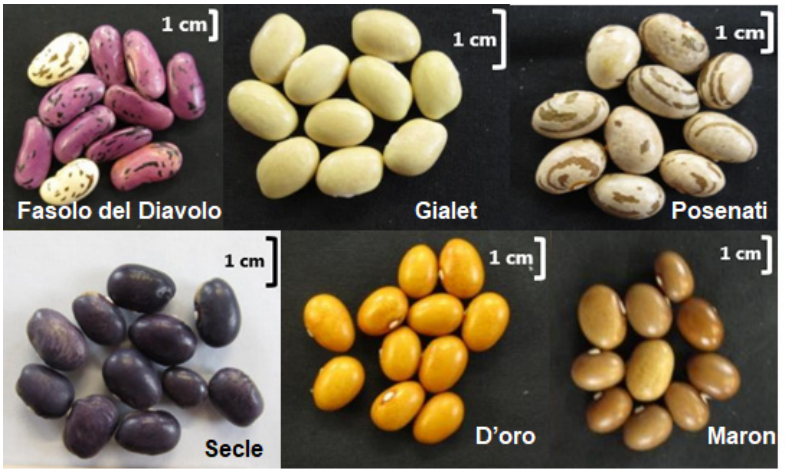
Figure 1. Seeds of landraces used in this study, showing the high diversity of visual traits and potential for commercial interests.